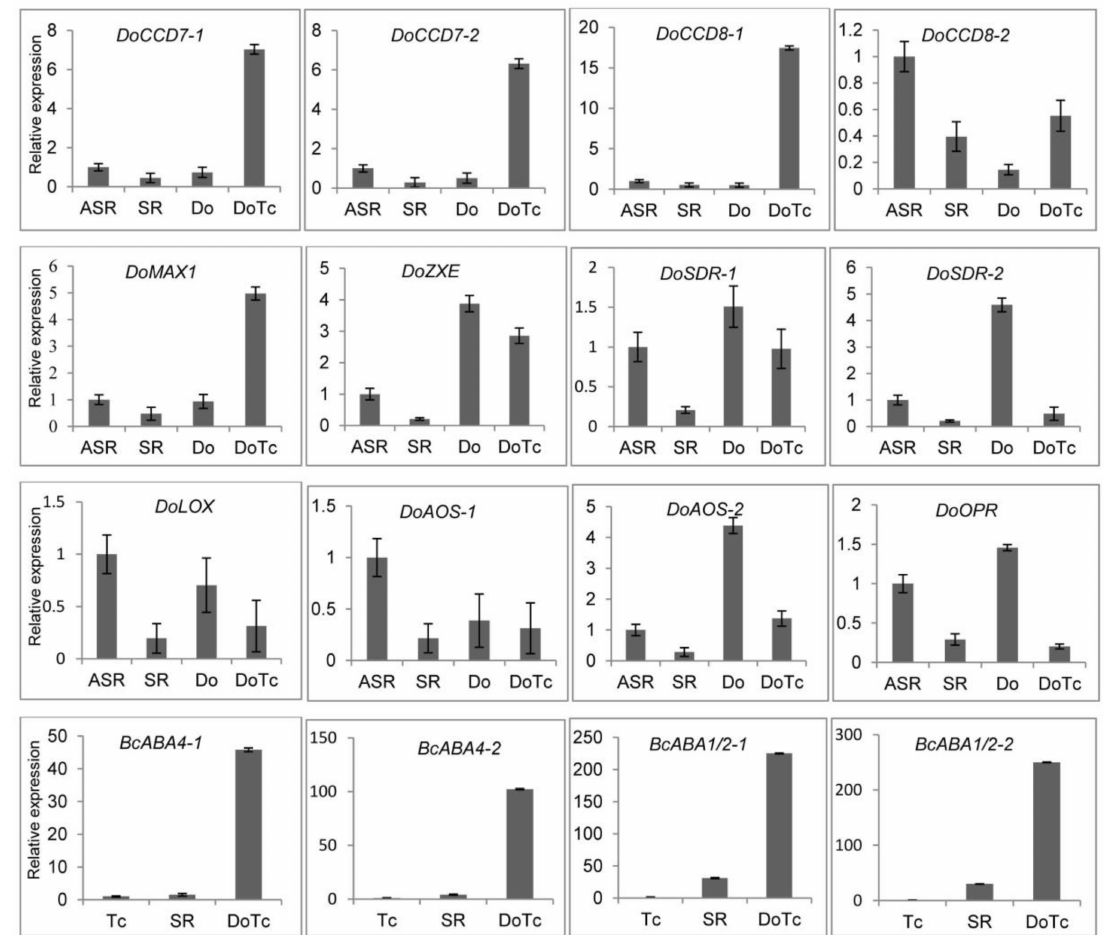
Figure 3. The expression levels of hormone biosynthesis-related genes determined by qRT-PCR. DoTc: symbiotic germinated seeds; Do: asymbiotic germinated seeds; SR: symbiotic roots of D. officinale seedlings; ASR: asymbiotic roots of D. officinale seedlings; Tc: free-living Tulasnella mycelium. Each data point represents the mean of three biological replicates and three experimental replicates. Bars represent the standard error of the mean, SE ( n =